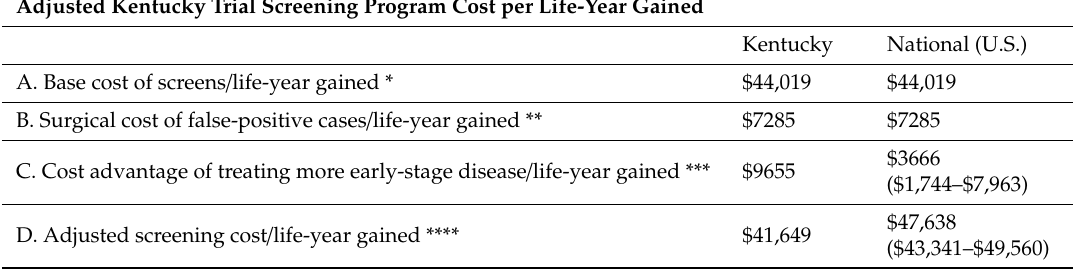
Table 4. Kentucky trial screening costs per life-year gained adjusted for the surgical cost of false positives and the cost advantage of treating more early-stage disease.